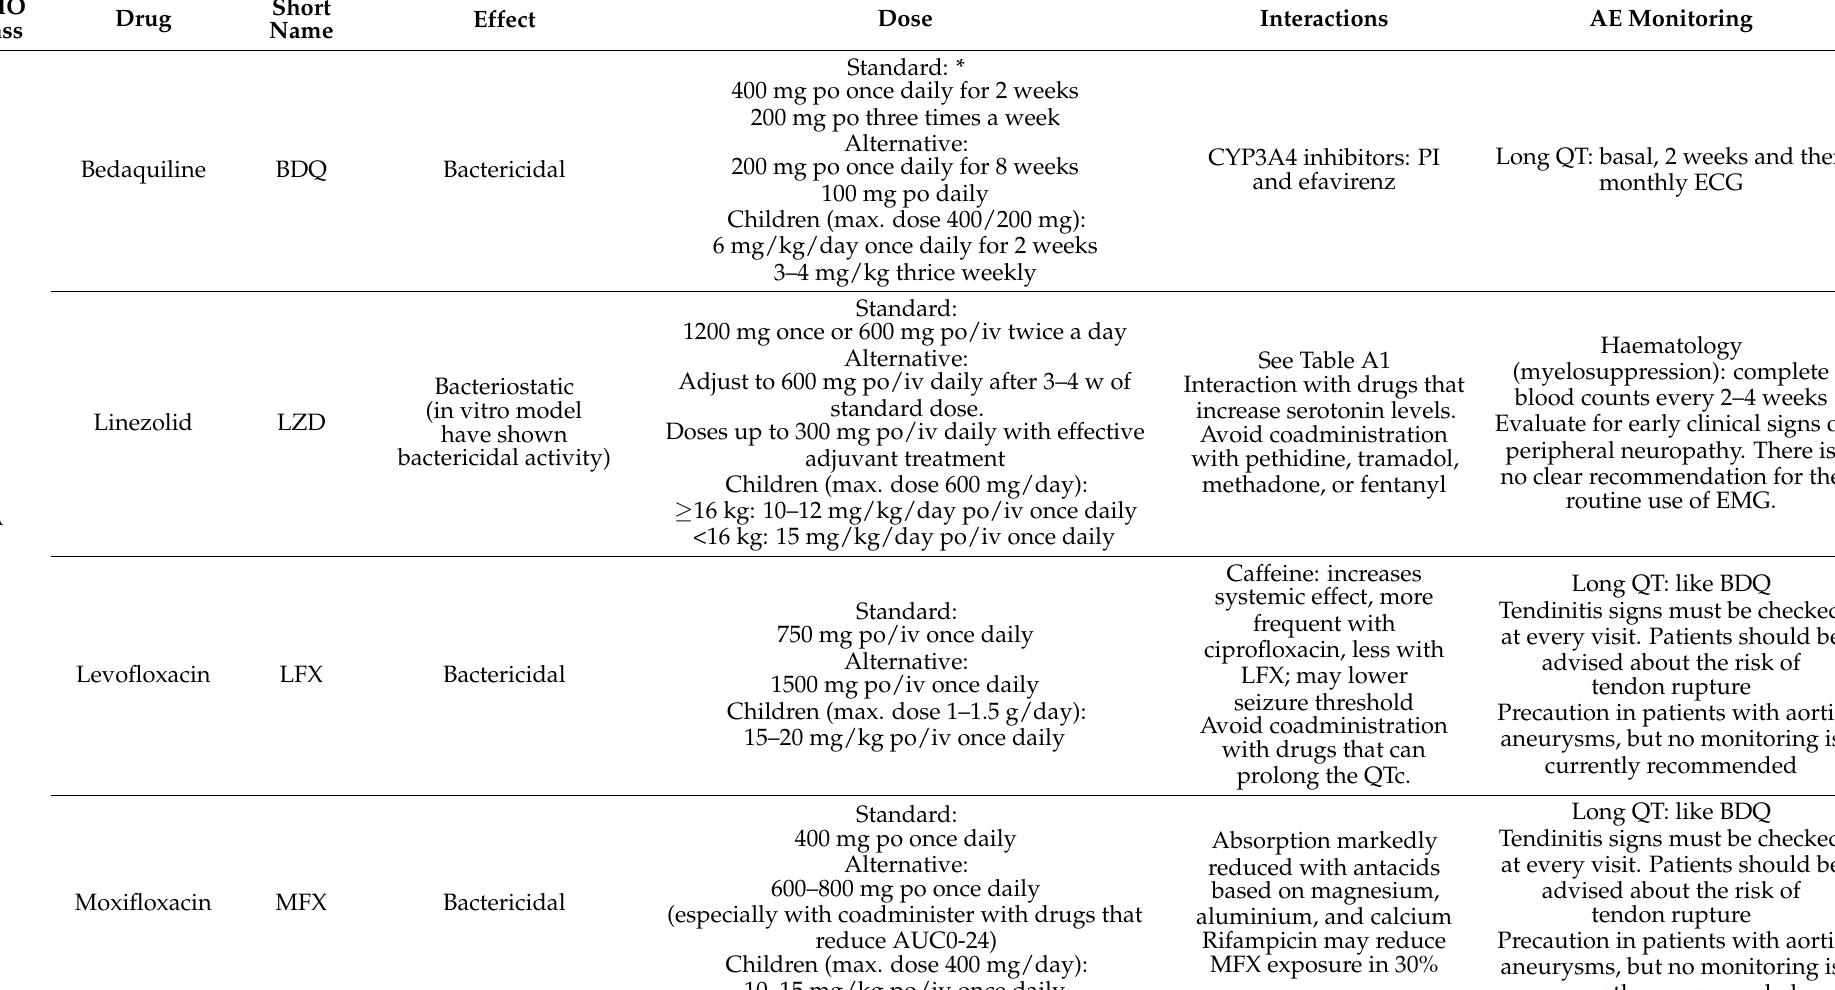
Table 2. Summary of drugs for